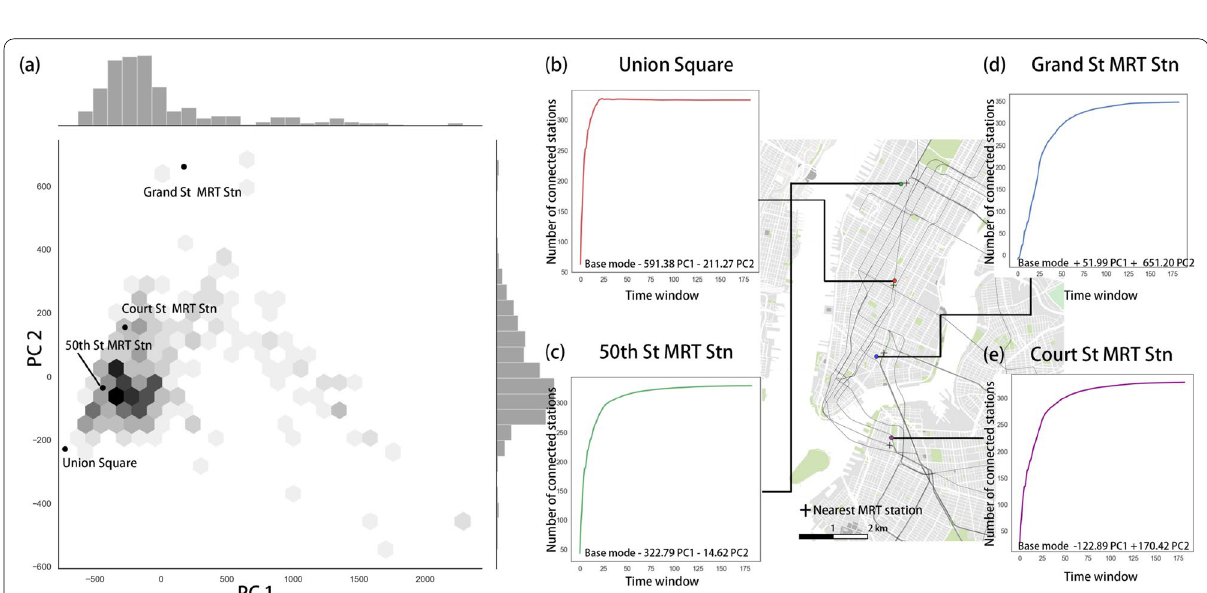
Fig. 10 Eigendecomposition of station growth